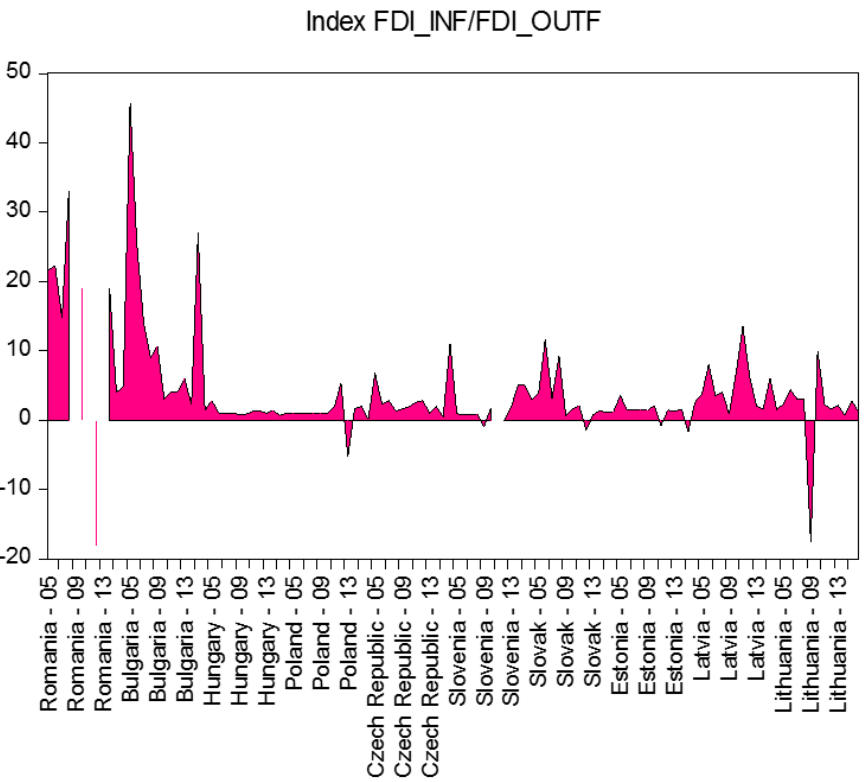
Figure 6. Evolution of the financial direct investment inflow (FDI_INF) / financial direct investment outflow (FDI_OUTF) index for the CEE countries.